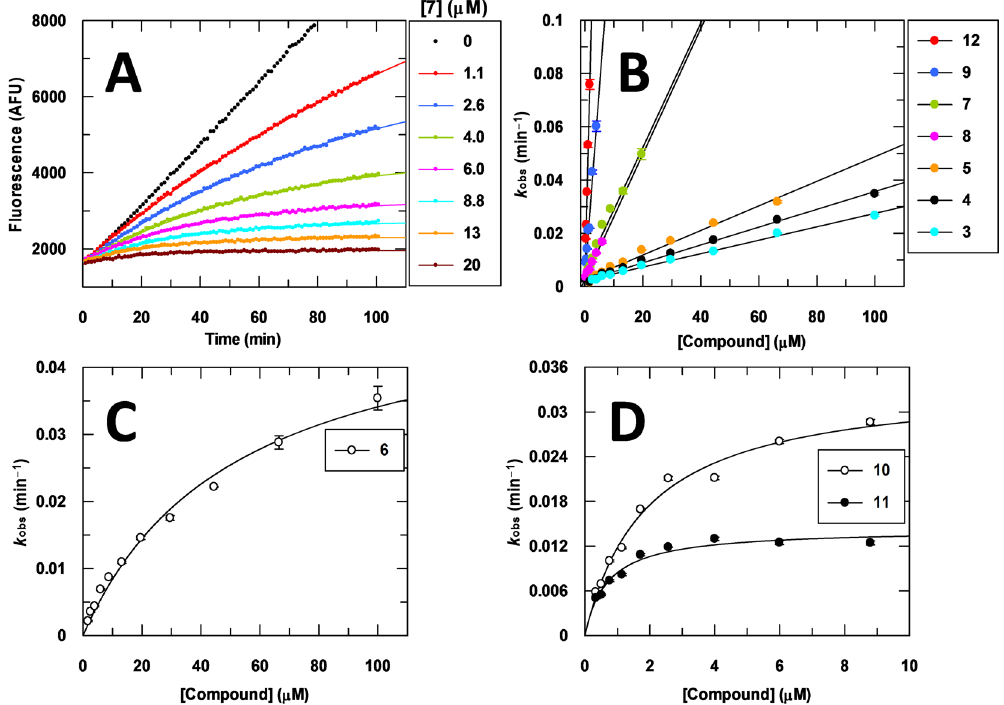
Figure 2. Progress curve analysis of inhibiton of Mtb-DprE1 by covalent inhibitors. ( A ) Representative time courses illustrating time dependent inhibition of Mtb-DprE1 by compound 7. ( B – D ) Dependence of k obs on inhibitor concentration for a series of BTZs and